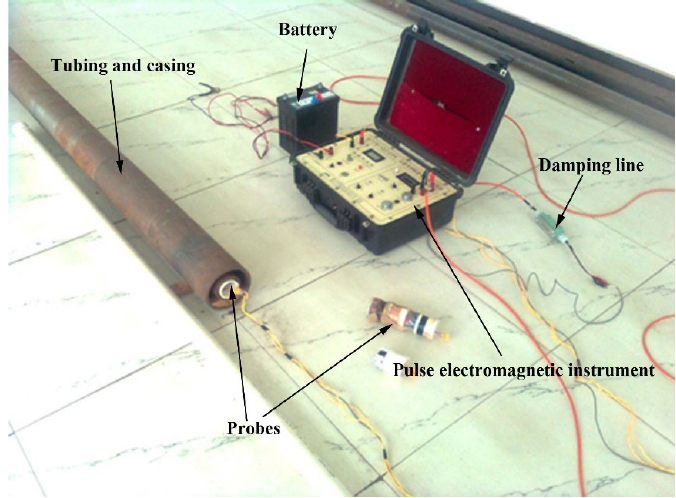
Figure 1. Experiment platform for tubing and casing inspection with PEC method.